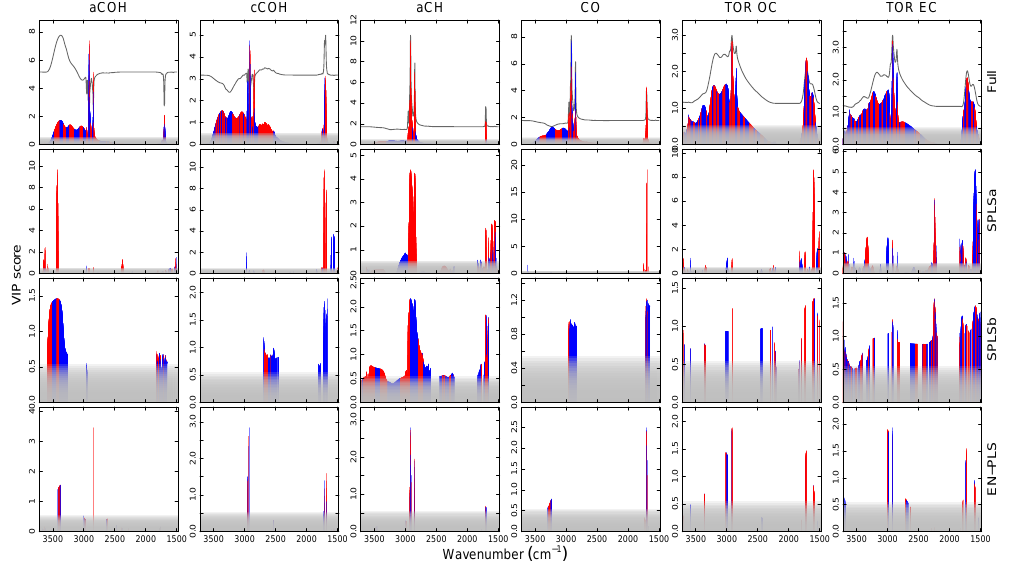
Figure 7. VIP for solutions using baseline corrected spectra. Lines and colors are as indicated for Fig. 6.